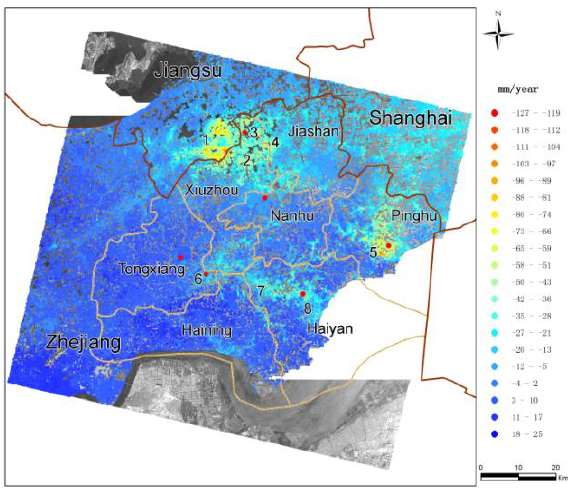
Figure 2. Average subsidence velocity in Jiaxing (2006-2010).